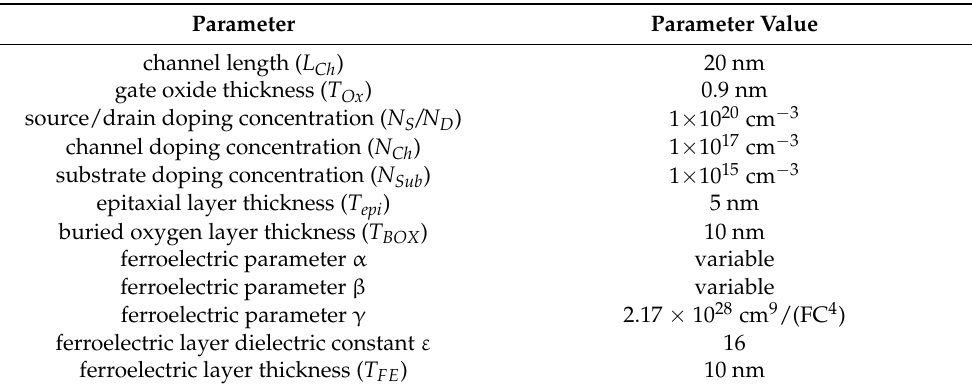
Table 1. DFR-NCFET transistor parameters table.